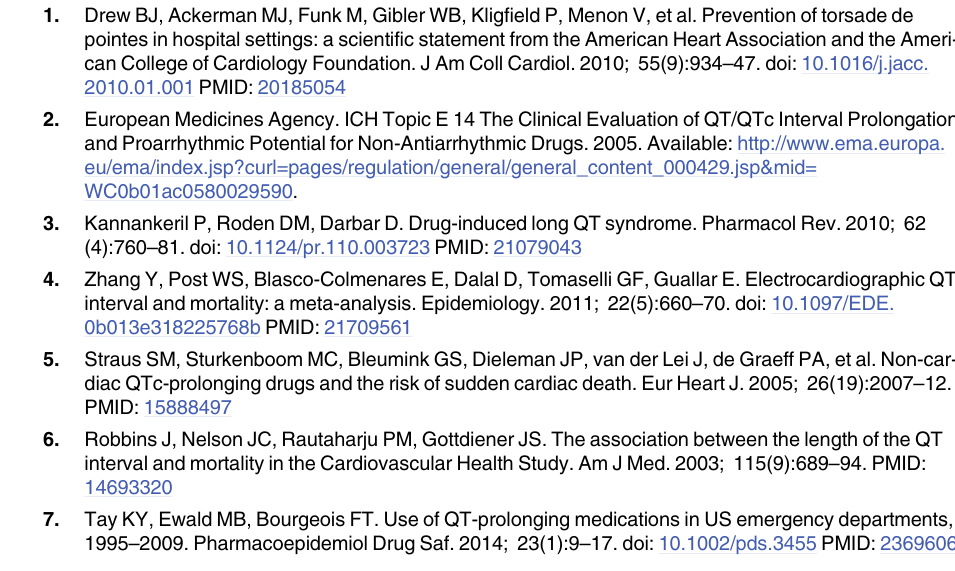
S3 Fig. TOP 10 list of the SmPC-high-risk-QT-drugs in patients with at least two QT-drugs with this risk. The figure shows the number of the ten most prescribed drugs in patients with at least two QT-drugs of this group. S1 Table. Non-high-risk-QT-drugs with possible or conditional risk of QT-interval pro- longation (adapted from CredibleMeds 1 ). S2 Table. SmPC-non-high-risk-QT-drugs. S3 Table. TOP 20 list of the most common co-prescriptions in patients with at least one High-risk-QT-drug and at least one additional ALL-QT-drug. S4 Table. TOP 20 list of the most common co-prescriptions of two QT-drugs in patients with High-risk-QT-drugs only. S5 Table. TOP 20 list of the most common co-prescription of two QT-drugs in patients with SmPC-high-risk-QT-drugs